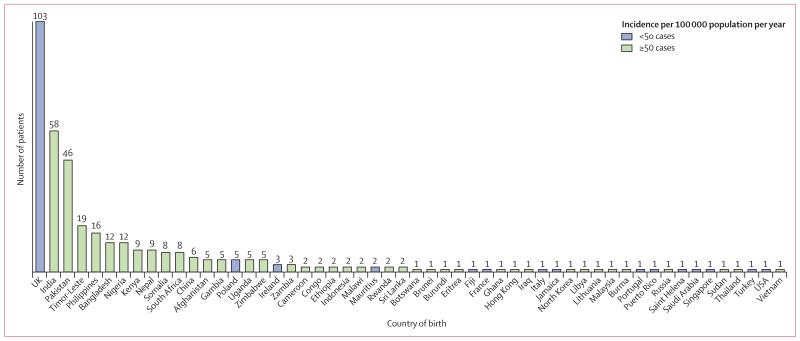
Country of birth of patients with tuberculosis in Oxfordshire, UK, 2007–12Country of birth was not known for four patients. High and low incidences defined according to WHO. 14